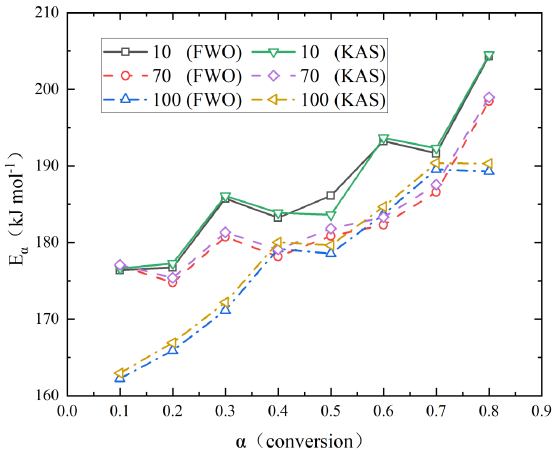
Figure 7. Distribution trend of activation energy of KAS method and FWO method with conversion rate. Table 2. Estimation of activation energy at each conversion based on FWO and KAS methods. KAS methods. Natural Aging — 10 α